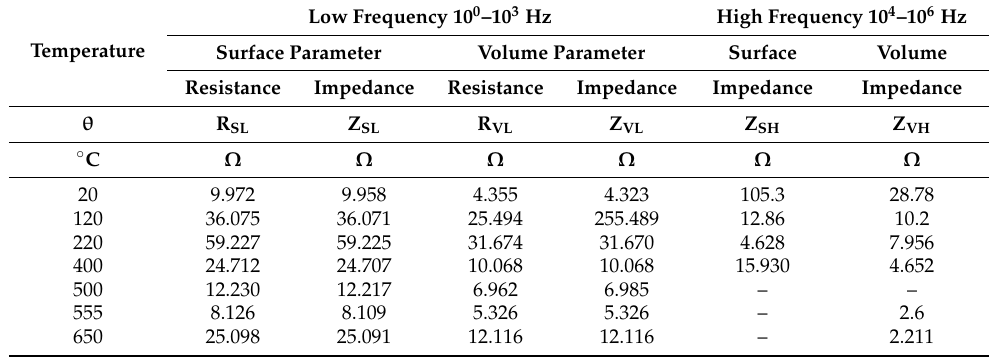
Table 4. Surface and volume electrical properties of Char at wider temperature and frequency.